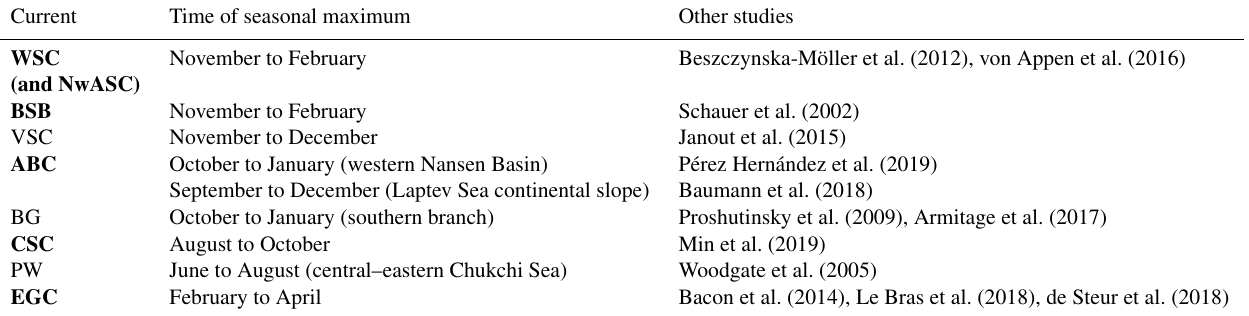
Table 6. Time of seasonal maximum occurrence in the currents of the Arctic Ocean in the results of this study. The abbreviations of the currents correspond to those indicated in Fig. 1, and slope currents are marked in bold. The third column indicates previous studies that find seasonality in agreement with our